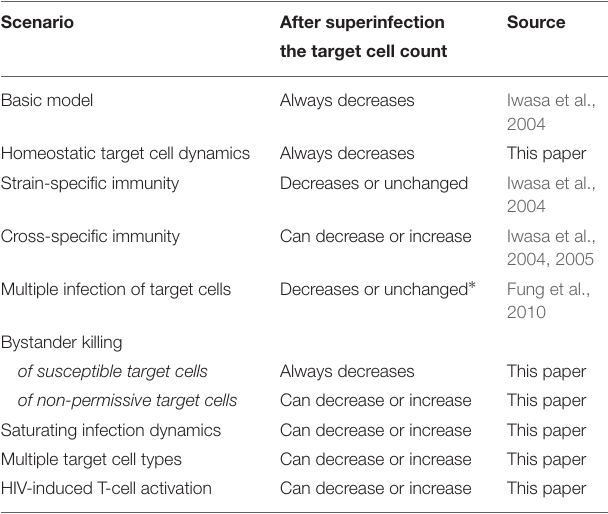
TABLE 6 | Possible outcomes of HIV superinfection on the total uninfected target cell